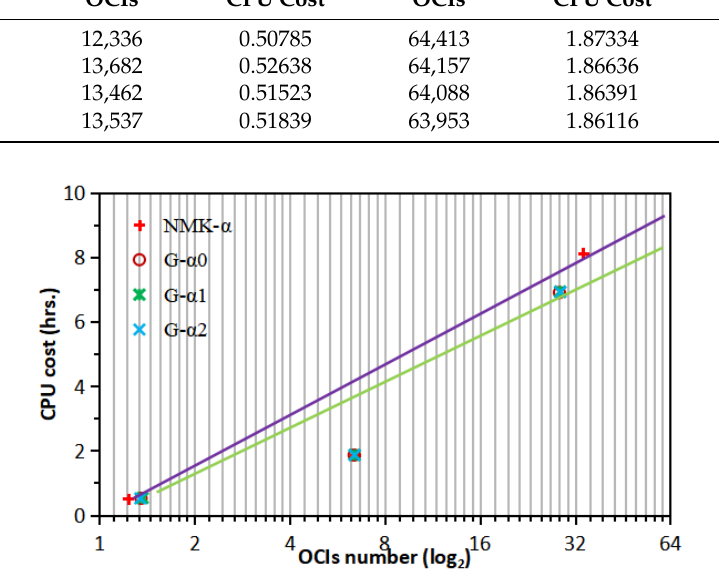
Figure 24. CPU cost versus OCIs by the referred algorithms.